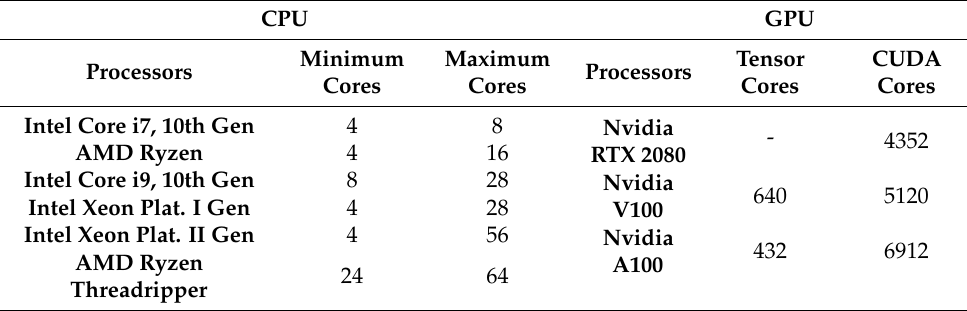
Table 3. Comparison of the number of CPU and GPU cores.